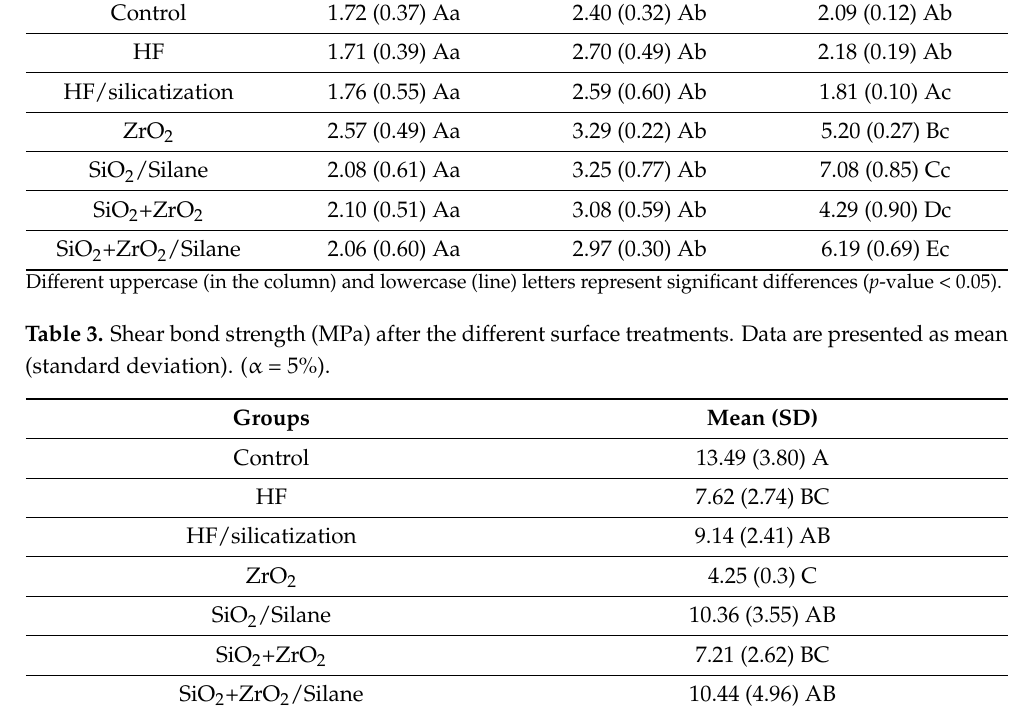
Different uppercase letters (in the column) represent significant differences ( p -value <